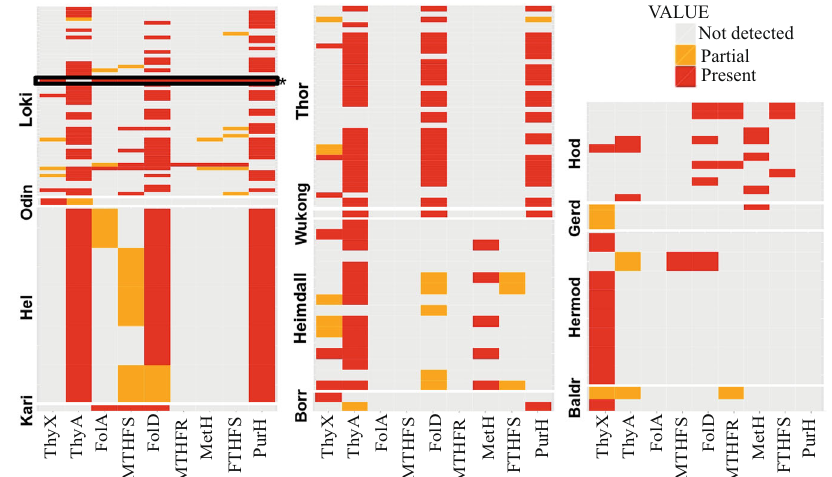
Fig. 2 | Heatmap for phyletic distribution of different folate-dependent enzymes in Asgard archaea. The red color indicates the presence of the entire gene, orange designates a partial copy. Psyn is indicated with an asterisk and